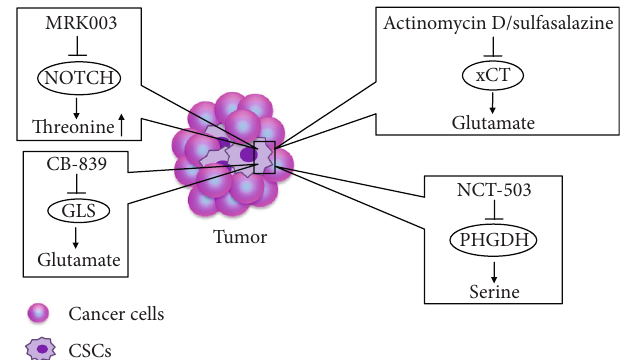
Figure 2: New therapeutic agents targeting AA